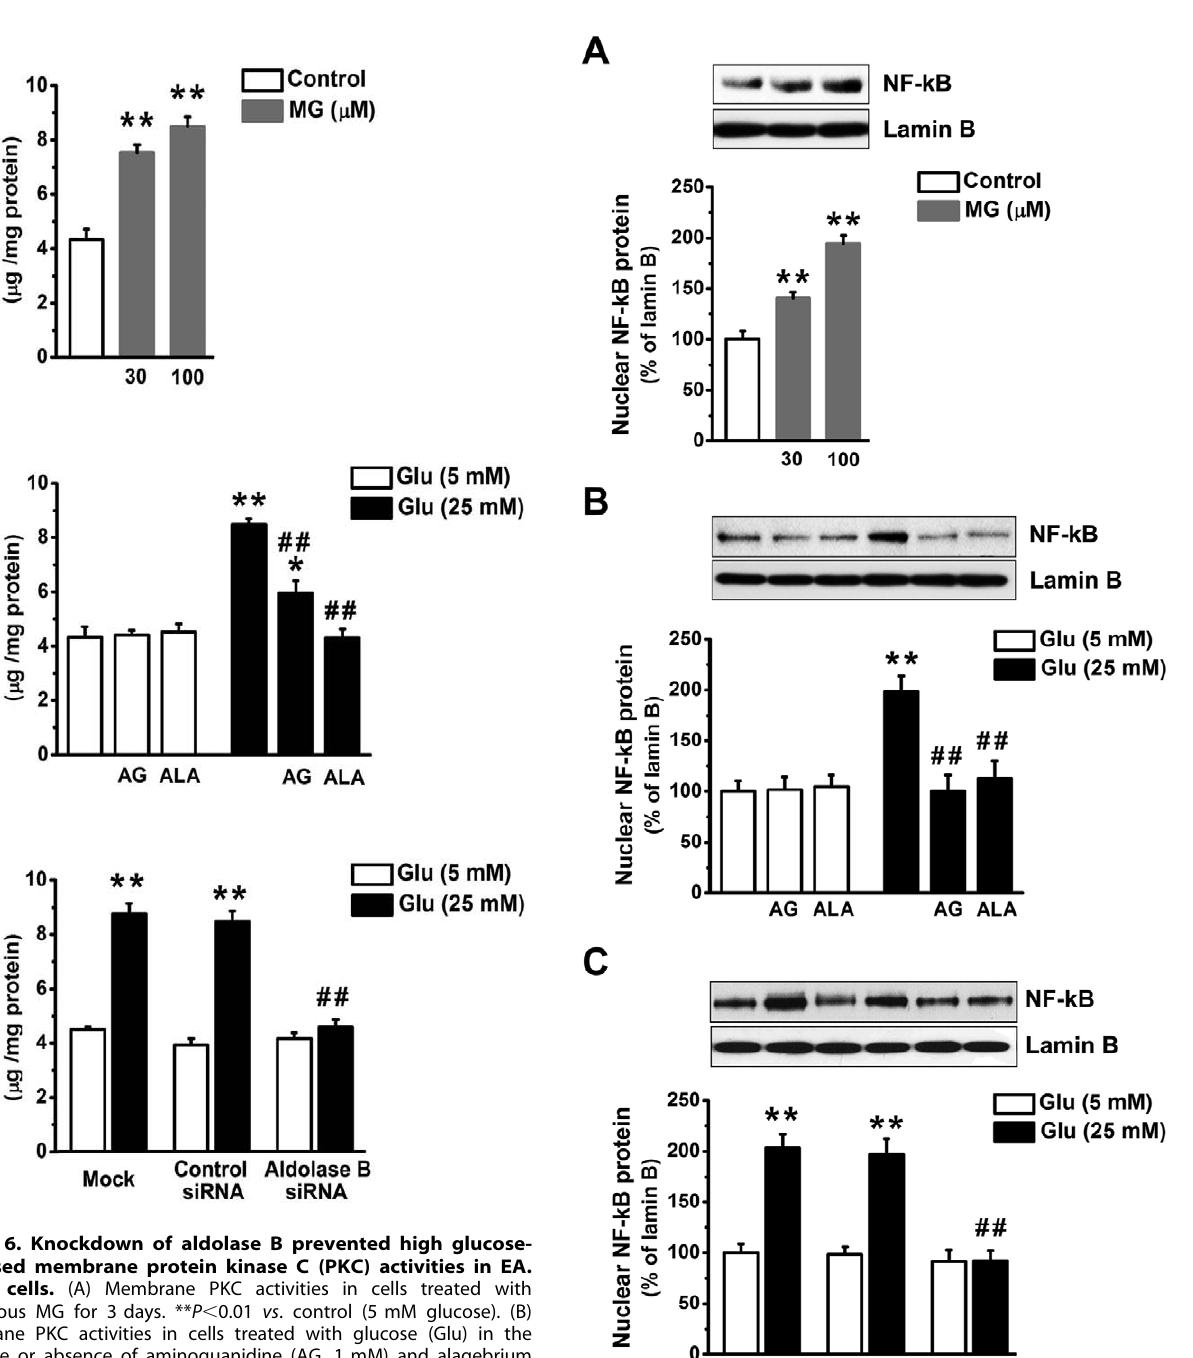
Figure 7. Knockdown of aldolase B prevented high glucose- increased NF- k B nuclear translocation in EA. hy926 cells. (A) Nuclear p65 subunit of NF- k B in cells treated with exogenous MG for 3 days. ** P , 0.01 vs . control (5 mM glucose). (B) Nuclear p65 subunit of NF- k B in cells treated with glucose (Glu) in the presence or absence of aminoguanidine (AG, 1 mM) and alagebrium (ALA, 100 m M). ** P , 0.01 vs . 5 mM glucose; ## P , 0.01 vs . 25 mM glucose. (C) Nuclear p65 subunit of NF- k B in cells transfected with control or aldolase B siRNA, or only transfection agent (mock). ** P , 0.01 vs . 5 mM glucose; ## P , 0.01 vs . control siRNA.